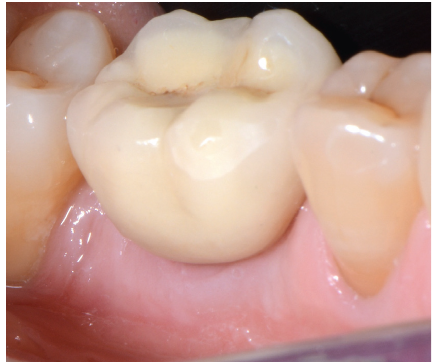
Figure 11: Clinical view of the restoration immediately after fitting the restoration.